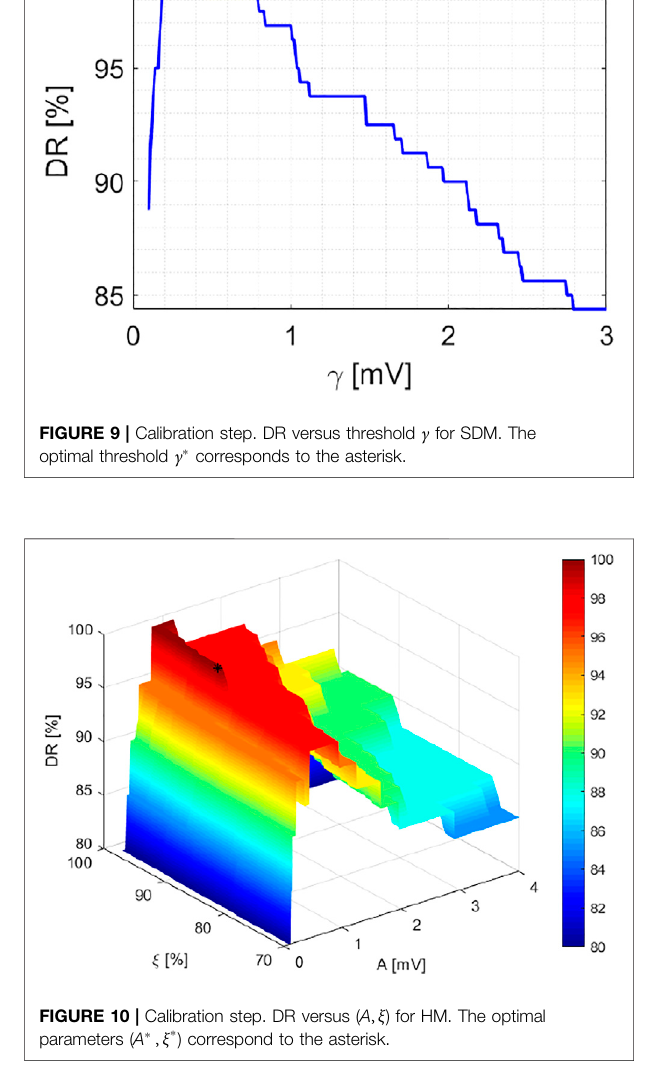
Frontiers in Signal Processing |